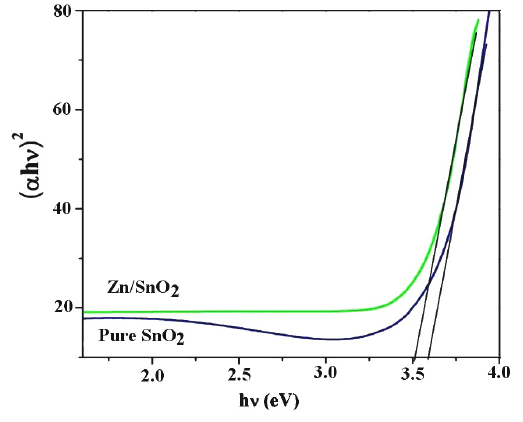
Fig.7 Plot of (αhν)2 Vs photon energy of pure and Zn-doped SnO nanoparticles Fig.8. Dielectric constant of Zn-doped SnO